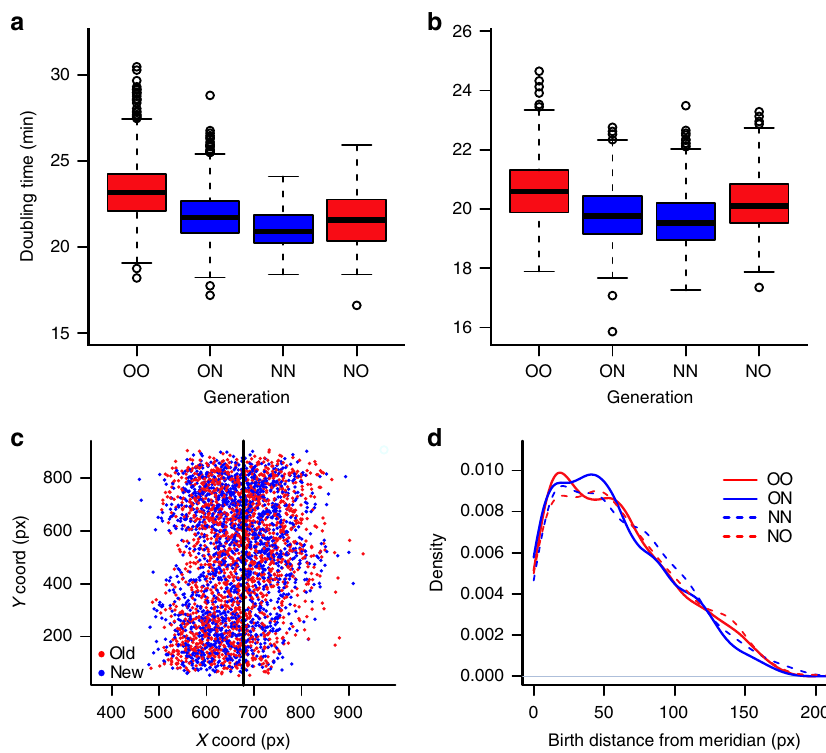
Fig. 2 Doubling time asymmetry in the absence of starvation and stress. a Bacteria from the mother machine were categorized as OO, ON, NN, and NO ( n = 882, 882, 105, 105 cells), re fl ecting their polarity and position within the growth traps. ON cells displayed faster doubling times than OO. Similarly, NN grew faster than NO (two-tailed paired t -test, t = − 2.308, df = 104, p = 0.023) despite the latter being closer to the nutrient source. b Doubling times of OO, ON, NN, and NO cells ( n = 556, 556, 620, 620 cells) from the daughter device showed the same pattern as in the mother machine. The doubling time relationships OO > ON ( t = − 17.219, df = 555, p < 0.001) and NO > NN ( t = − 13.564, df = 619, p < 0.001) were again veri fi ed by two-tailed paired t tests. Boxplots show median (center line), fi rst and third quartiles (box limits), and minimum and maximum (whiskers). c Representation of cells within the chamber, according to their coordinates at birth. The vertical line represents the midline of the chamber, which is open along the Y axis on both sides. d We analyzed the data from c by measuring the distance of each cell from the midline of the chamber at the moment of birth, and veri fi ed no localization bias among sibling pairs within the daughter device (OO – ON p = 0.12 and NO – NN p = 0.98, Wilcoxon signed-ranks test). Therefore, doubling time